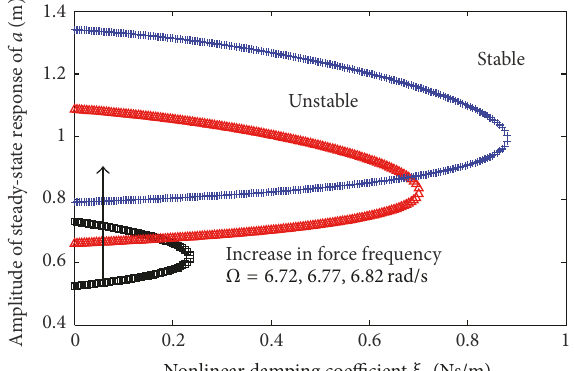
Figure 10: The effect of varying force frequency Ω on unstable area of vibration 𝑎 . Ω = 6.77 rad / s (black squares), Ω = 6.87 rad / s (red triangles), and Ω = 6.97 rad / s (blue